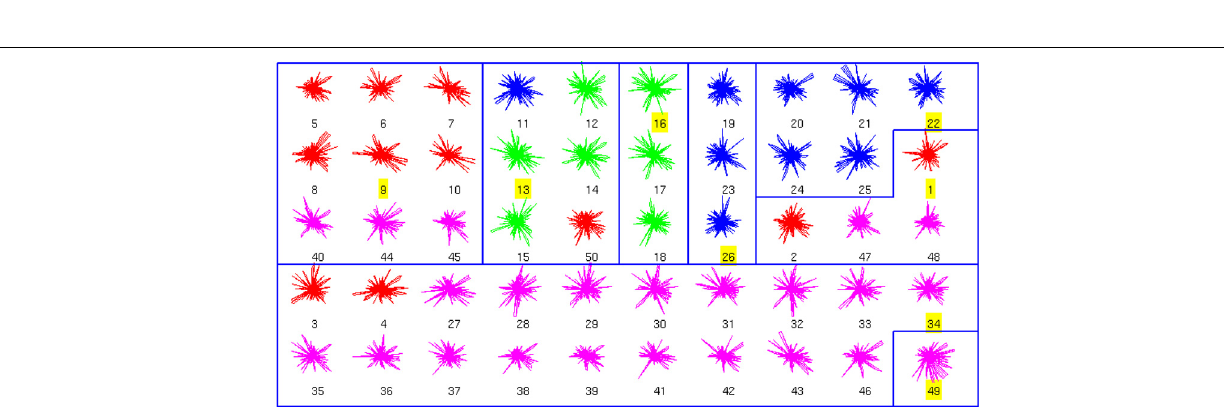
FIGURE 2 | Physiological Clusters. Code as in Figure 1 . See text for details on the clusters.